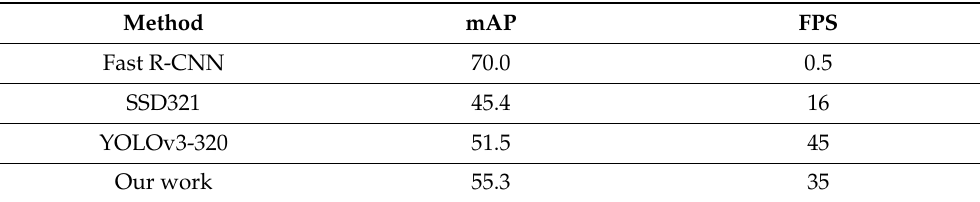
Table 3. The performance comparison of various object detection